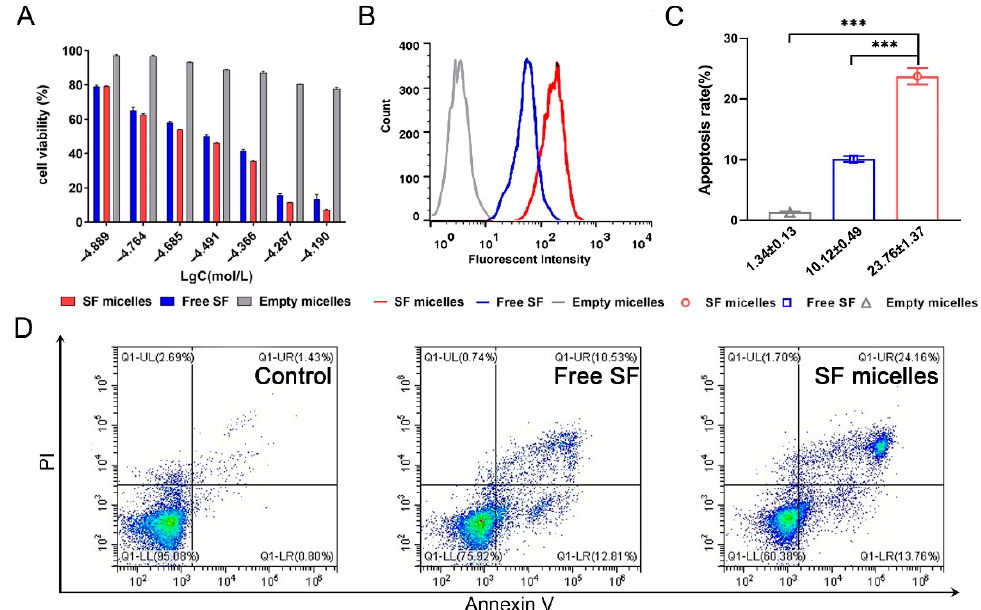
Figure 4. Cellular uptake and cytotoxicity in TC-1 cells. ( A ) In vitro cytotoxicity of Free SF, Empty micelles, or SF micelles after 24 h of co-incubation in TC-1 cells (n = 3, mean ± SD). ( B ) Flow cytometry analysis on the fluorescent intensity of cells after co-incubation for 4 h with Free SF and C6-labeled Empty micelles or SF micelles. ( C ) Cell apoptosis were measure by flow cytometry with Annexin V-FITC and propidium iodide (PI) staining after co-incubation with Free SF, Empty micelles, or SF micelles in TC-1 cells (n = 3, mean ± SD). ( D ) Typical apoptotic cell images. Significance criteria: *** p < 0.001.